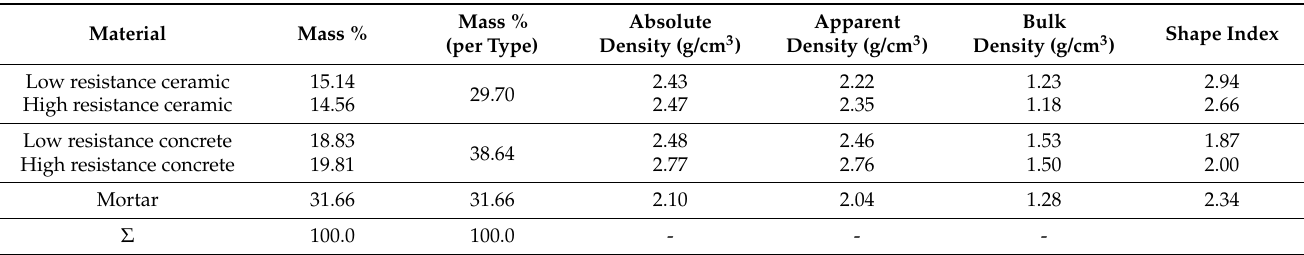
Table 2. Mass composition of the feed mixture and individual densities of constituents (see Section 2.4 for details about density characterization).